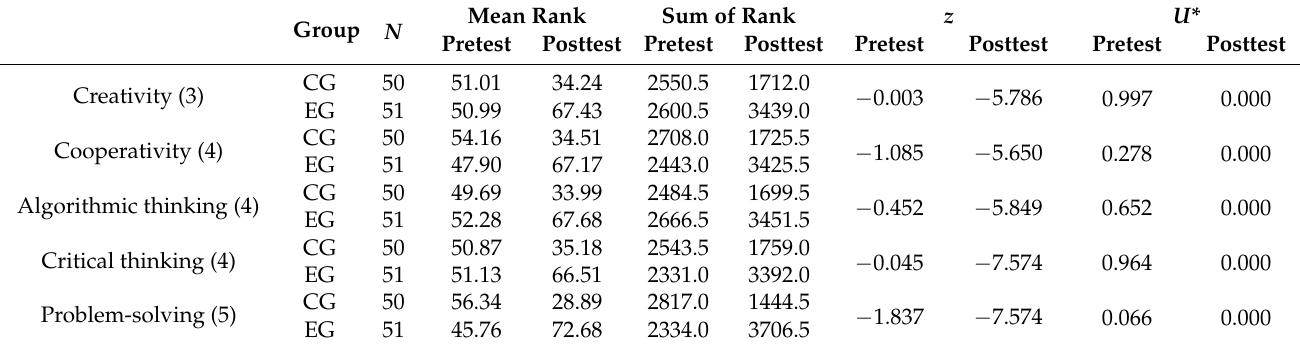
Table 4. Mann–Whitney U test results from the pretest and posttest scores of the experimental and control groups.